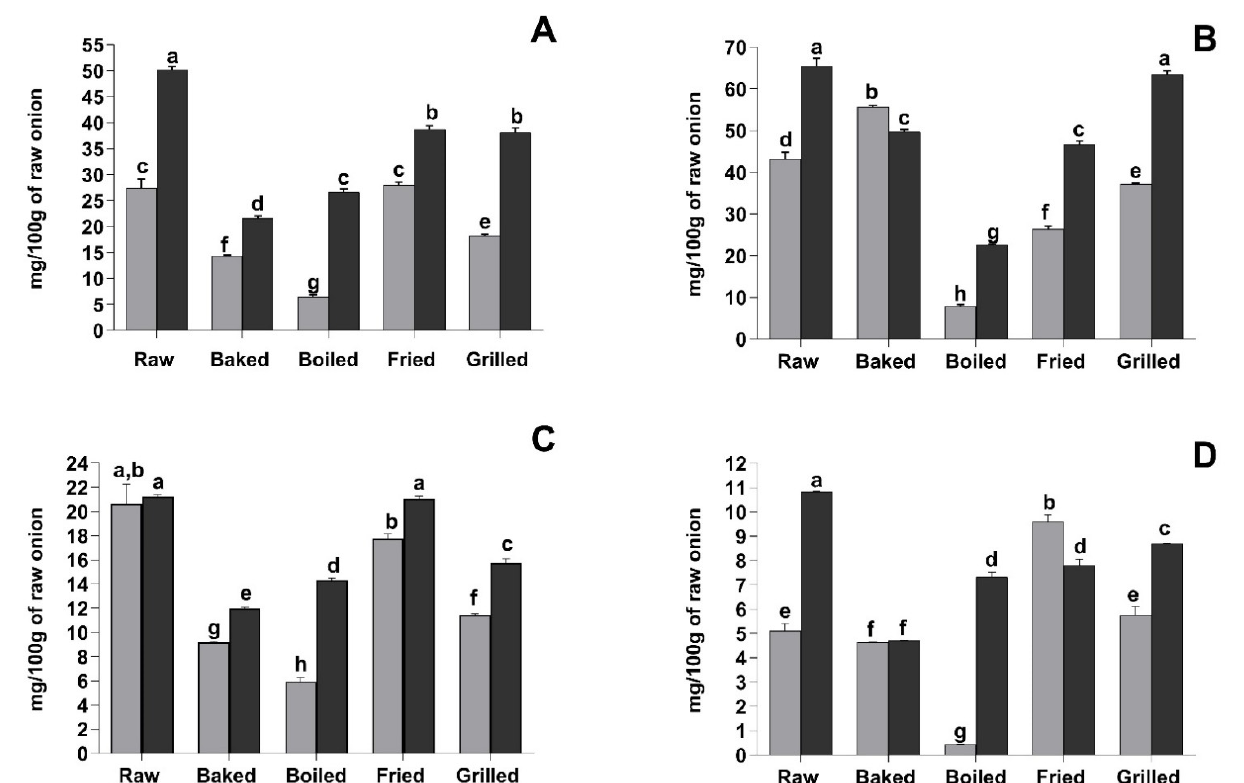
Figure 1. Effect of different cooking methods on YSO and RSO total phenolic compounds and quercetin-derivatives referred to the original fresh weight. Light grey bars indicated the YSO whereas black bars the RSO. ( A ) Total phenolic compounds measured by mass spectrometry. Results are expressed as mg/100 g of fresh weight. ( B ) Total phenolic compounds with the Folin-Ciocalteu’s assay. Results are expressed as mg of gallic acid equivalent/100 g of fresh weight. ( C ) Total quercetin-di-hexosides measured by mass spectrometry. Results are expressed as mg/100 g of fresh weight. ( D ) Total quercetin-mono-hexosides measured by mass spectrometry. Results are expressed as mg/100 g of fresh weight. Different letters mean significant difference ( p < 0.05).